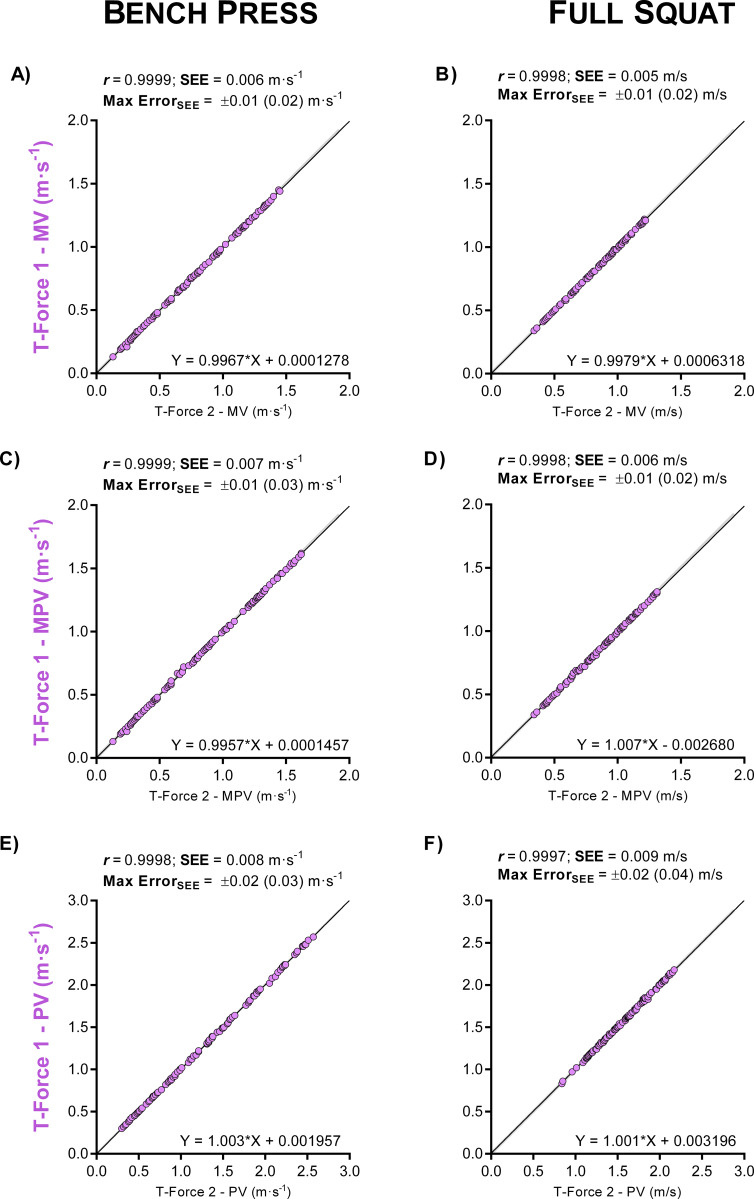
Intra-device agreement between two T-Force devices.Bland–Altman plots for the velocity readings in bench press (A, C and E panels) and full squat (B, D and F) exercises. Panels are ordered by velocity outcomes: mean velocity (MV), mean propulsive velocity (MPV) and peak velocity (PV). The grey shaded area indicates an acceptable level of agreement between devices, which results in differences in terms of load ≤ 5% 1RM [26,27].